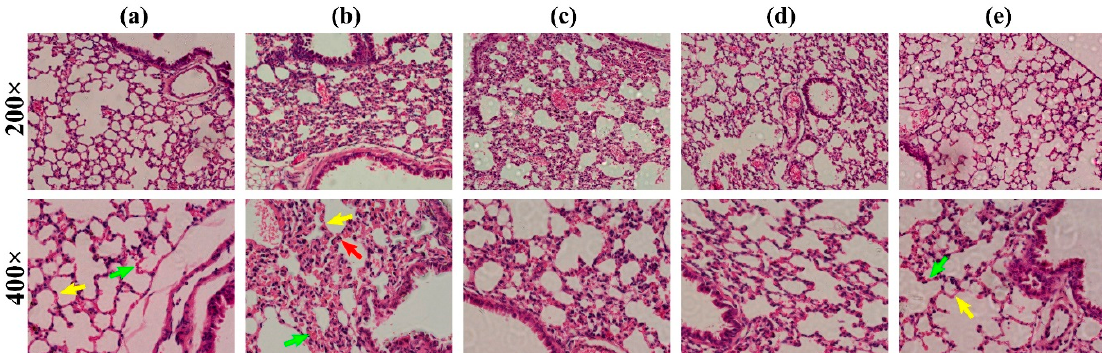
Figure 7. Lung tissue histology analysis. ( a ) Representative hematoxylin and eosin-stained mouse lung sections with control group. ( b ) Mouse lung sections of PM 2.5 group. Arrows point out the thickened alveolar septum, dilated telangiectasia, and neutrophil. ( c ), ( d ), and ( e ) Mouse lung sections with treatment of 1-MHD, ASP, and 2 , respectively. Note: Red arrow, neutrophil; yellow arrow, alveolar septum; green arrow, capillaries.